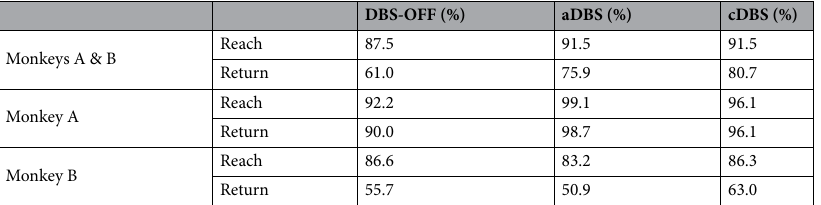
Table 2. Success rates for the task with DBS-OFF, adaptive DBS (aDBS), and constant DBS (cDBS). Ratio (%) of successful trials with reaching the target (Reach) or returning to the home key (Return) among trials